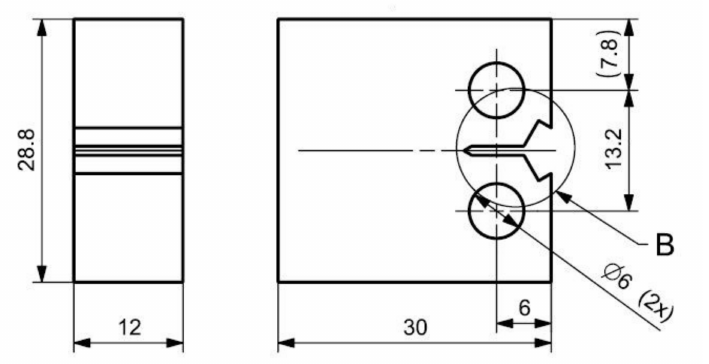
Figure 2. Compact tension testing specimen layout, dimensions in mm.